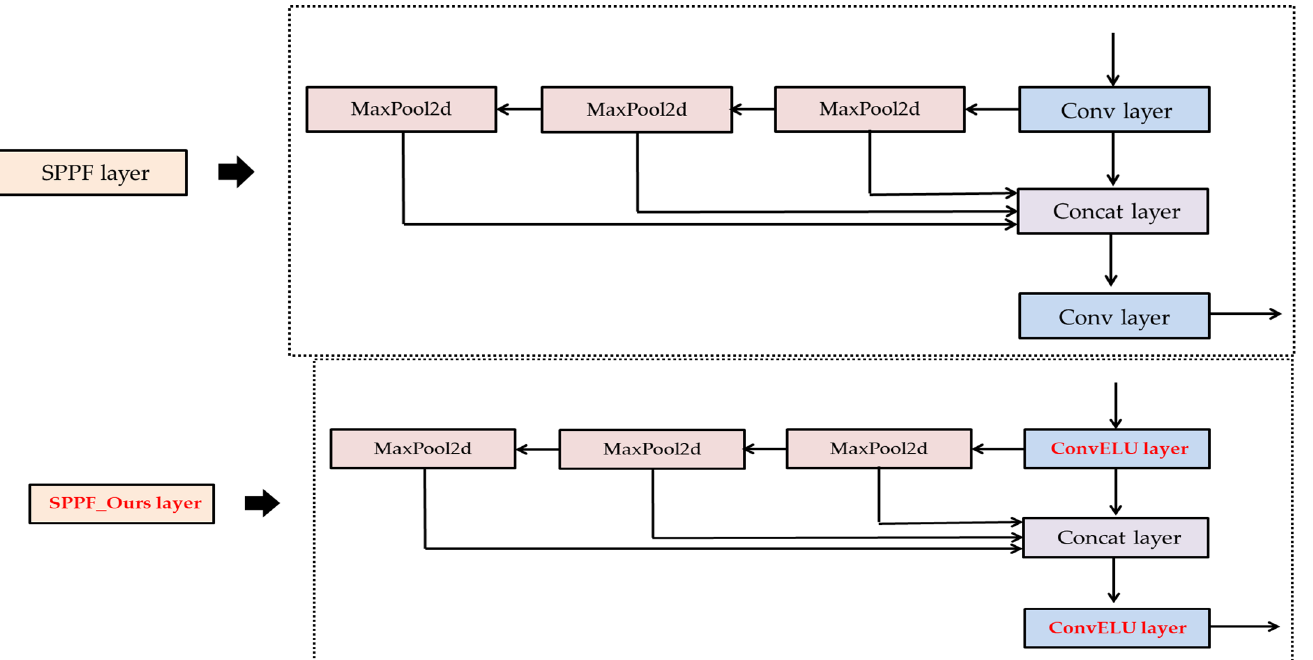
Figure 4. Comparison of original C3 and C3_Ours layer ( Left figure is the existing layer, Right figure is the way we suggest it).